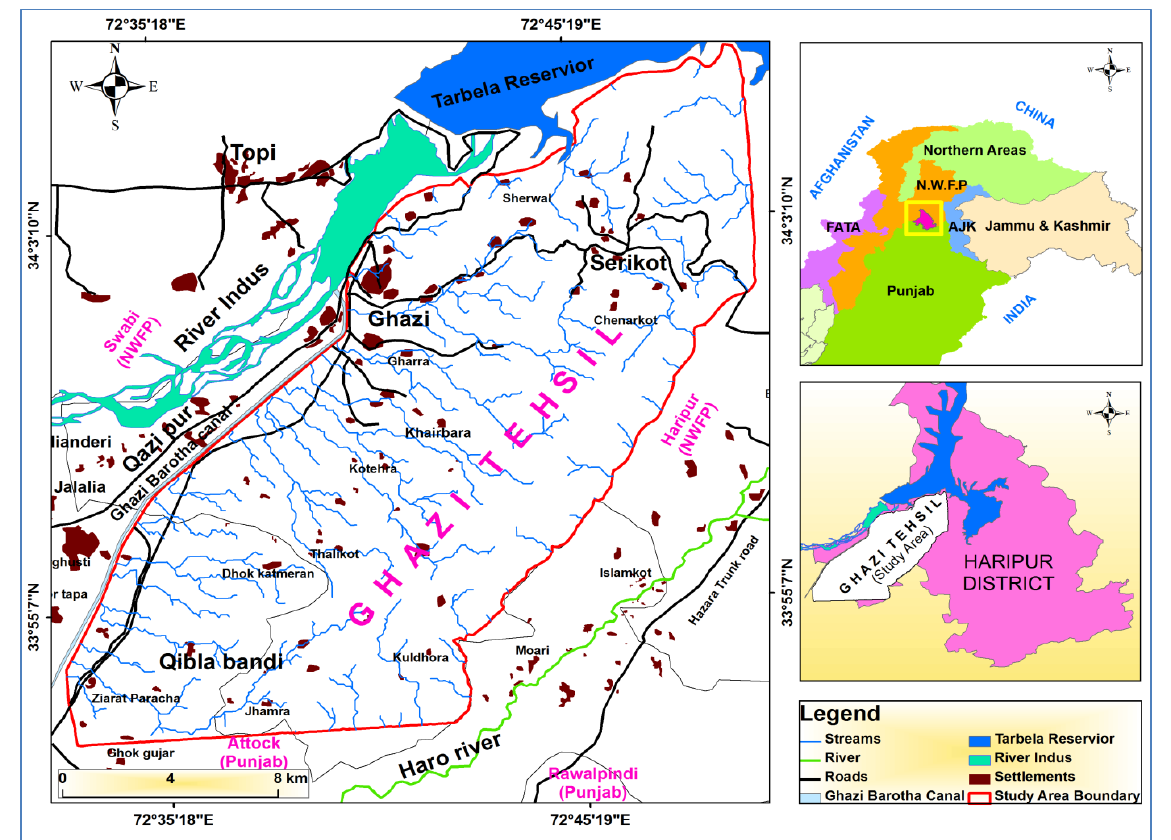
Figure 1. Location map of the study area.